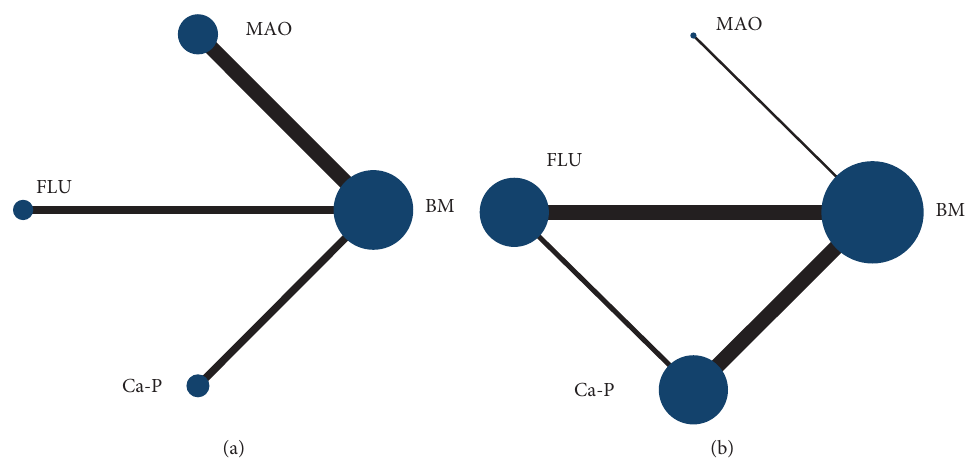
Figure 7: Network structure (a) % degradation and (b) new